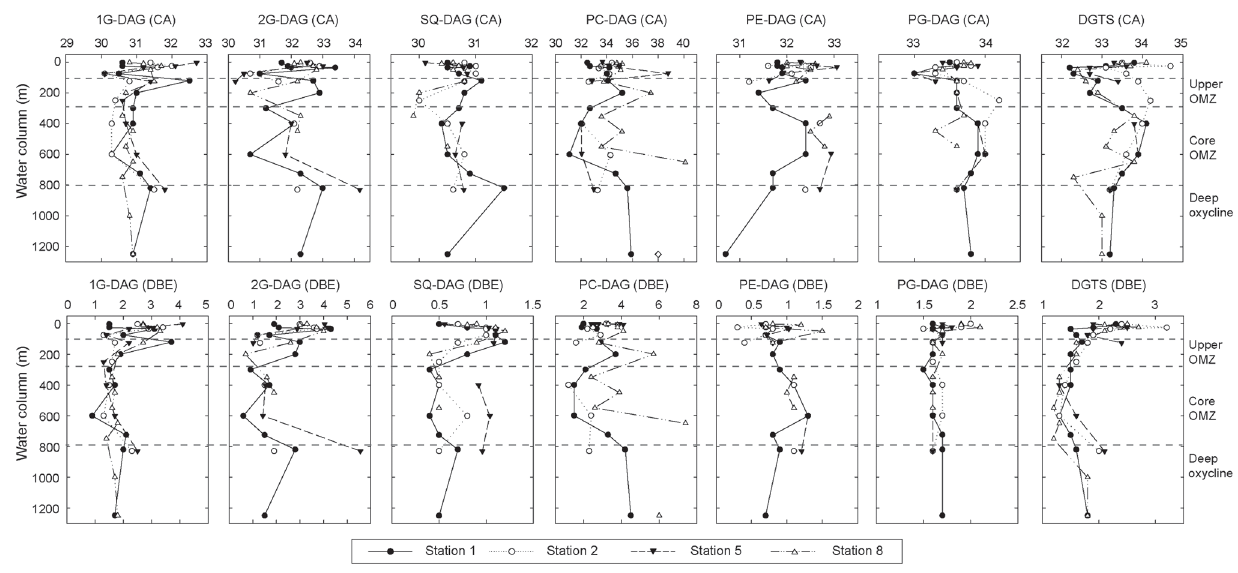
Figure 5. Changes in average carbon atoms (CA) and number of double bond equivalents (DBE) of the alkyl side chains of major IPLs detected at Stations 1, 2, 5 and 8 in the